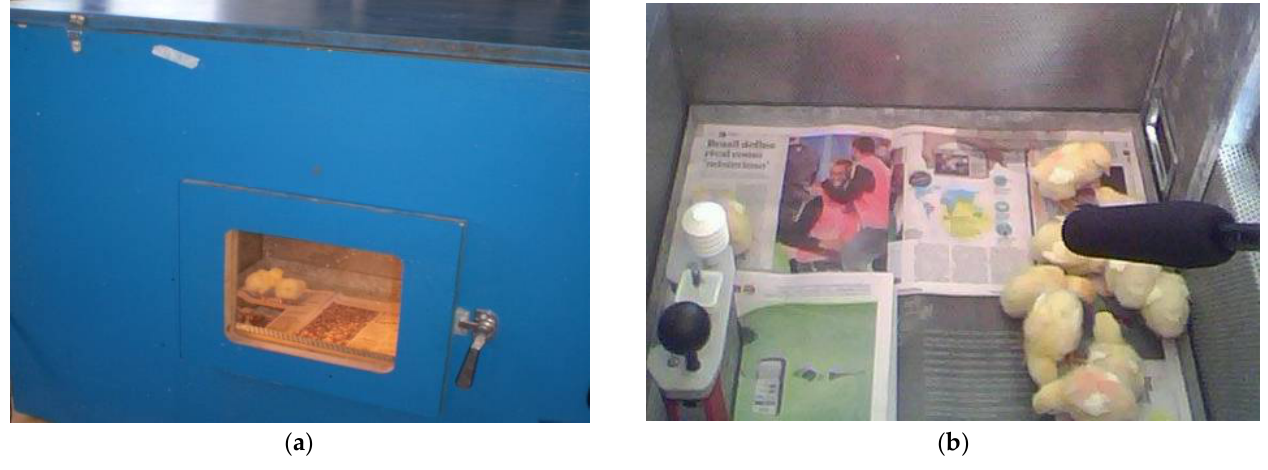
Figure 1. Experiment views: ( a ) Outside the anechoic chamber; ( b ) Inside the anechoic chamber showing the chickling on the floor covered with newspaper and the vocalization and the environmental temperature recording to ensure a thermoneutral ambient.